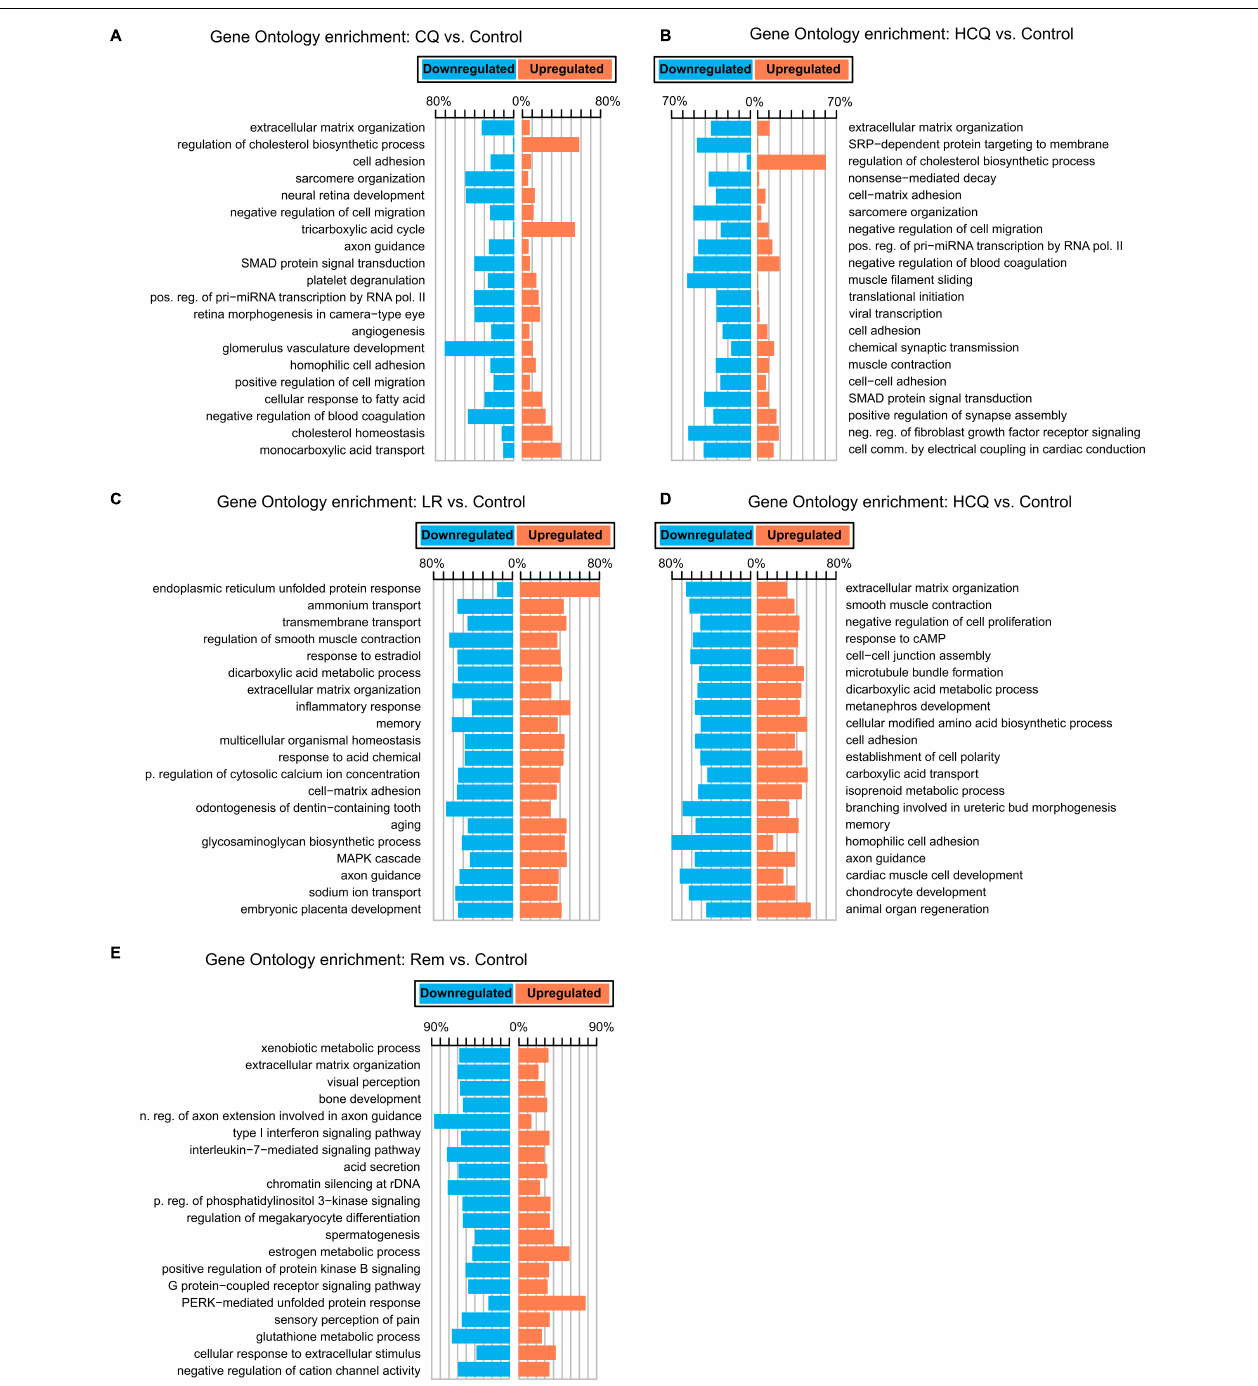
FIGURE 2 | Gene Ontology (GO) functional enrichments for candidate COVID-19 treatments. (A) CQ vs. control. (B) HCQ vs. control. (C) LR vs. control. (D) LRI vs. control. (E) Rem vs. control. FDR ≤ 0.05. CQ: chloroquine; HCQ: hydroxychloroquine; LR: lopinavir/ritonavir; LRI: lopinavir/ritonavir + interferon- β ; Rem: remdesivir.